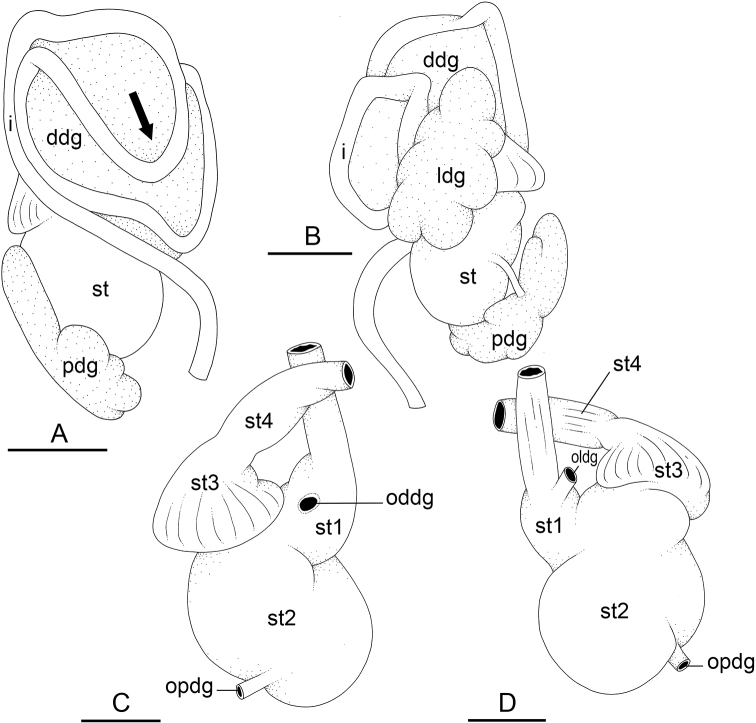
Digestive system, Peronia
verruculata (unit #1), Indonesia, Sulawesi [2127] (UMIZ 00170) A dorsal view, the arrow indicates the orientation of the transitional loop B ventral view C stomach, dorsal view D stomach, ventral view. Scale bars: 5 mm (A, B), 4 mm (C, D). Abbreviations: ddg dorsal digestive gland, i intestine, ldg lateral digestive gland, oddg opening of the dorsal lobe of the digestive gland, oldg opening of the lateral lobe of the digestive gland, opdg opening of the posterior lobe of the digestive gland, pdg posterior digestive gland, st stomach, st1 first stomach chamber, st2 second stomach chamber, st3 third stomach chamber, st4 fourth stomach chamber.